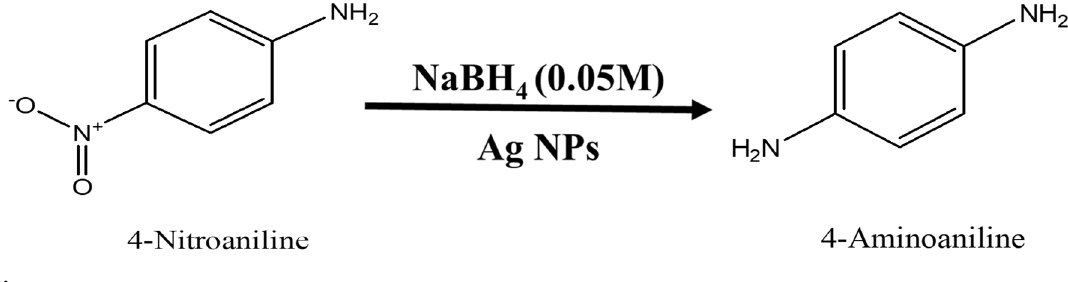
Figure 19. Schematic chemical reaction of conversion of 4-nitroaniline to 4-aminoaniline.